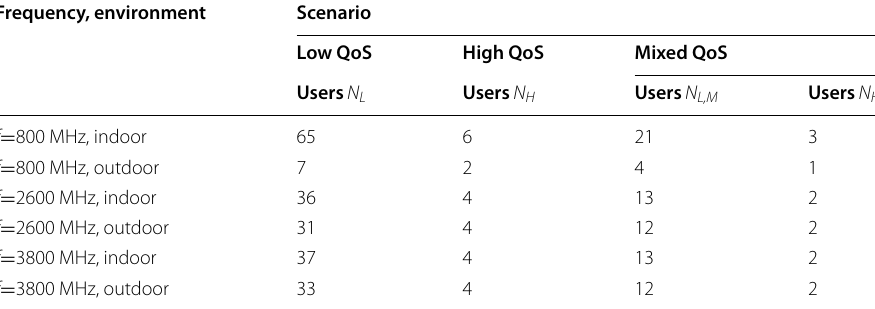
Table 2 Max. number of users that can be supported for the three QoS scenarios for the different values of the technical parameters Frequency,